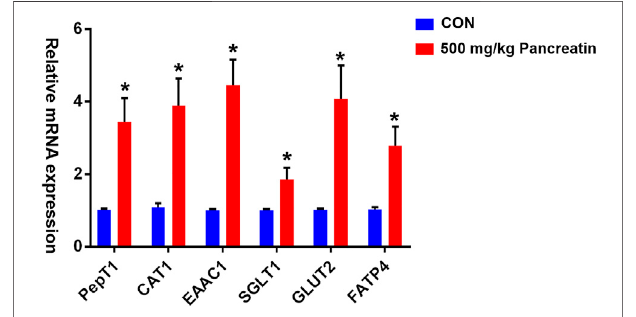
FIGURE1| Effectofpancreatinonjejunaltransportergeneexpressionin piglets (* represents signi fi cant differences, p < 0.05).